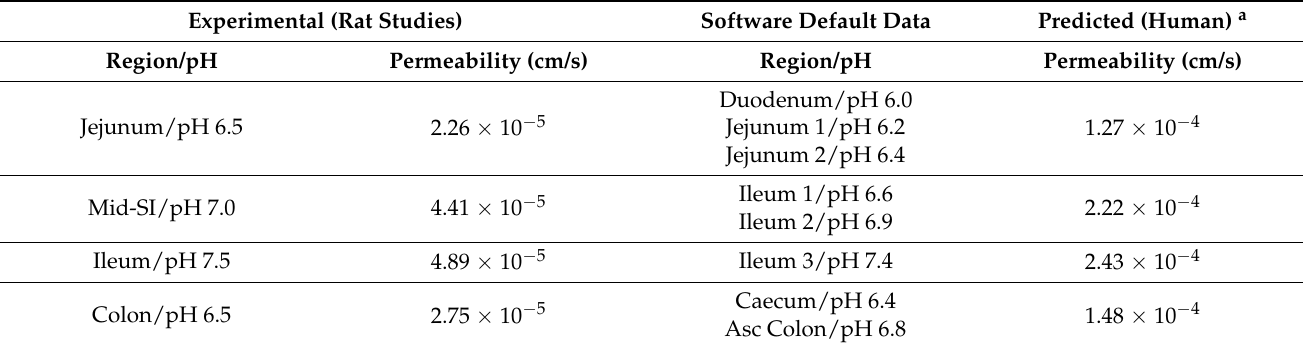
Table 2. Minoxidil permeability in relation to the regional pH values in the GI